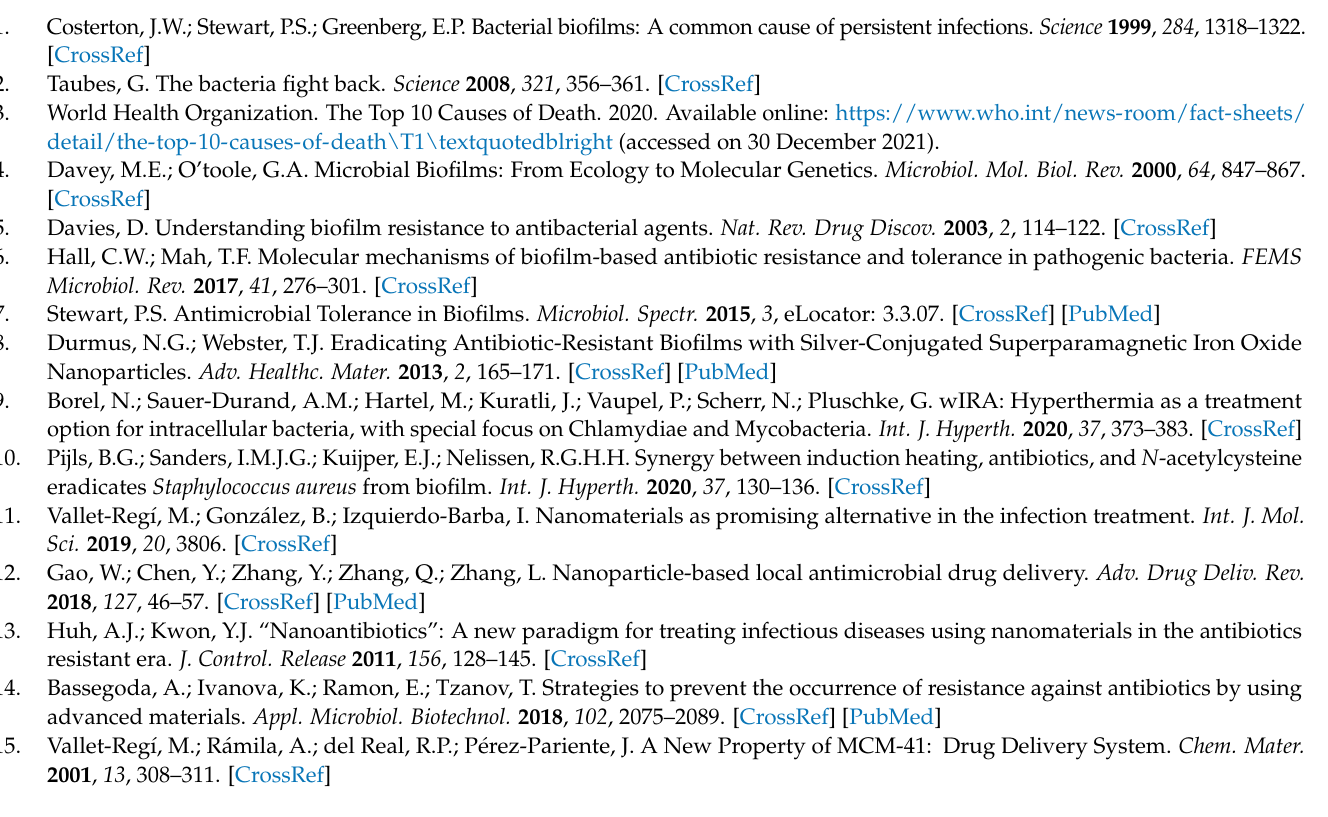
Figure S3: EDS spectrum and atomic percentage of iron content in mesoporous silica nanosystem; Table S1: Kinetic parameters of LEVO release at different temperatures (20, 37 and 50 ◦